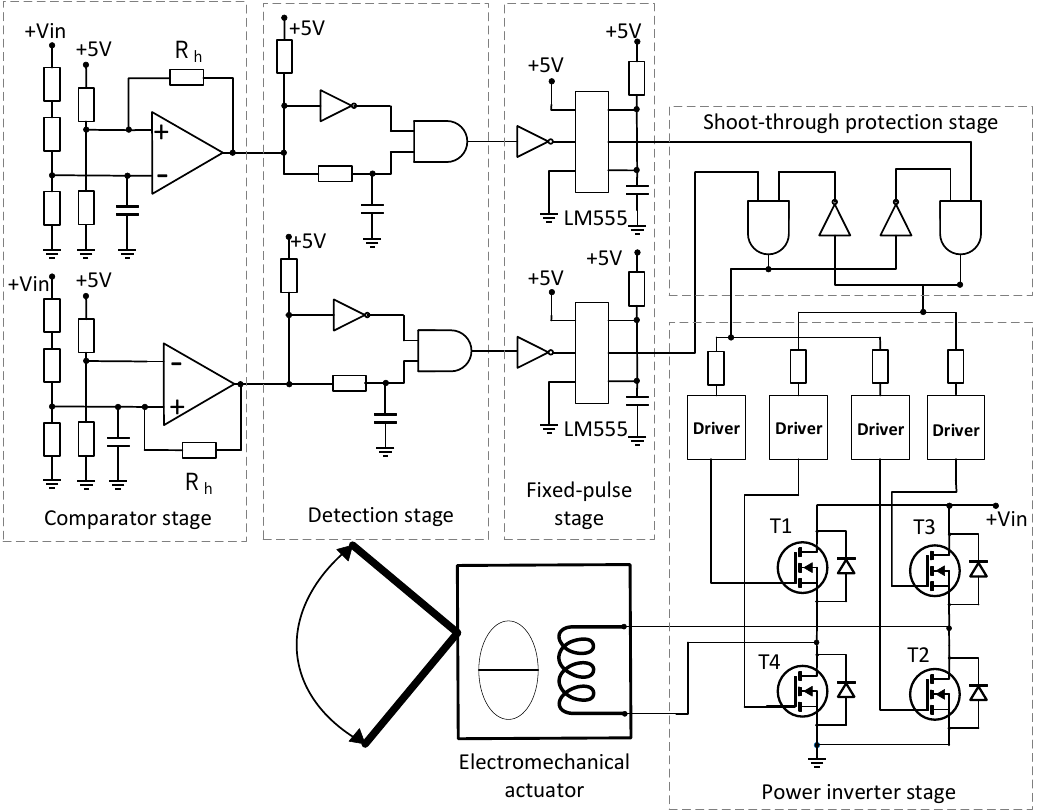
Figure 8. Current flow schematic for the proposed angular bipolar control.